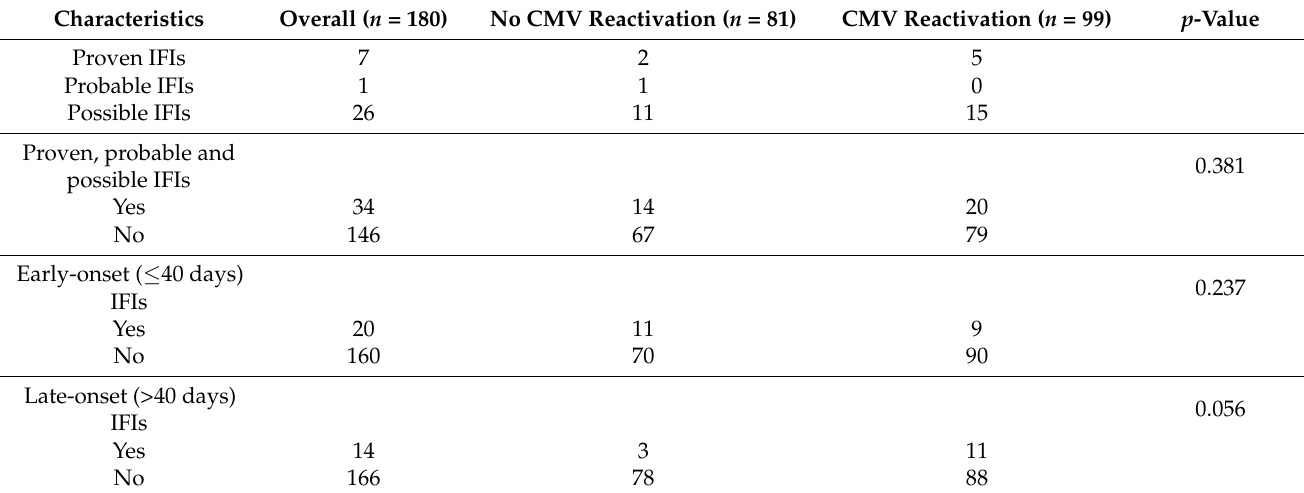
Table 4. Characteristics of CMV reactivation and invasive fungal infection (IFI) within 100